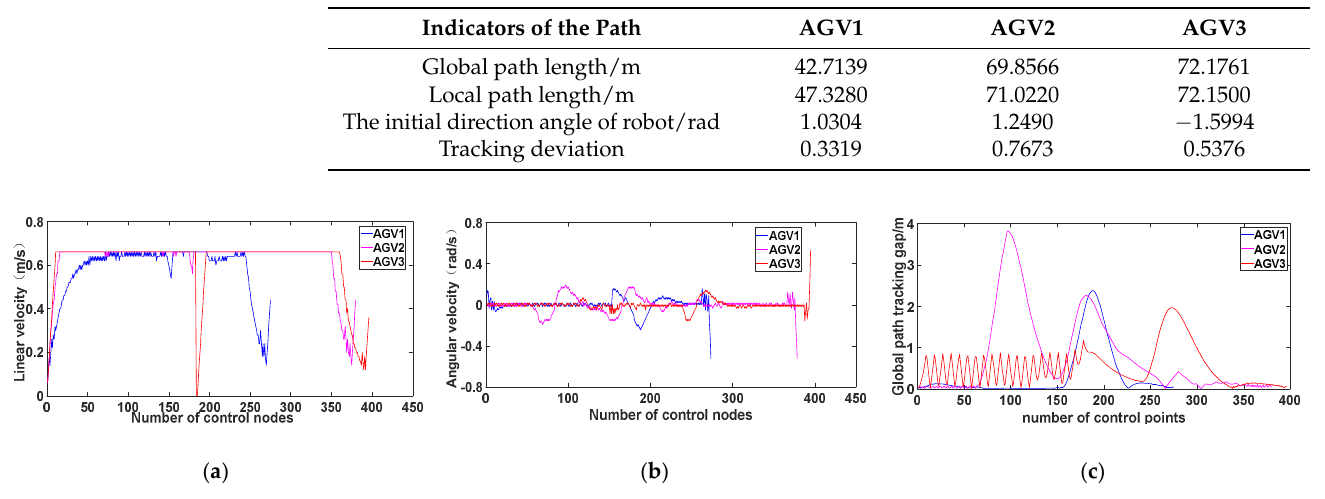
Table 9. Multi-robot path planning results in an unknown static marine environment.